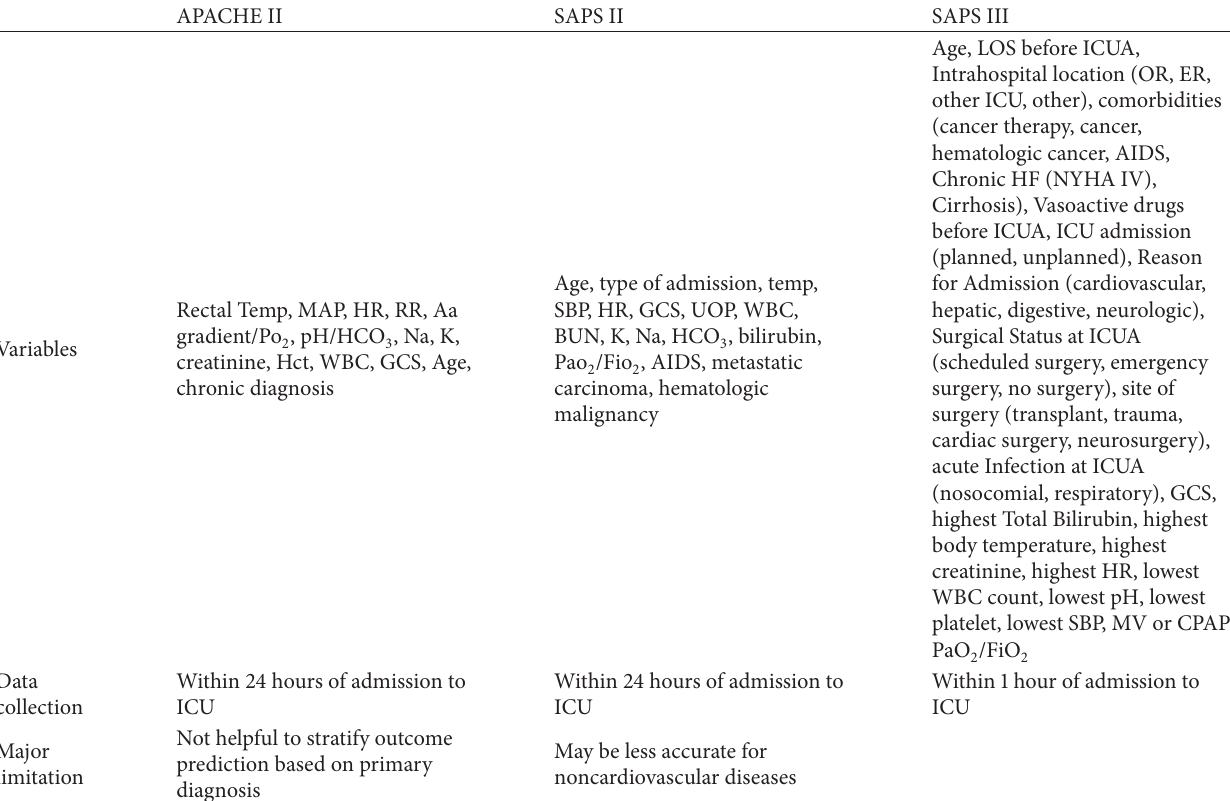
Table 1: Differences between APACHE II, SAPS II, and SAPS III severity scoring